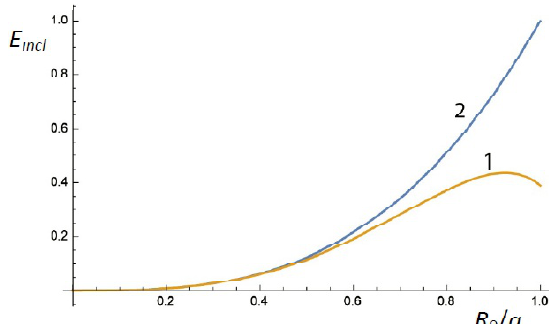
Fig. 5. The strain energy of a hemispherical dilata- tion inclusion E as a function of its normalized incl radius R / a in a sphere of finite radius a (curve 1) 0 and in an infinite medium (curve 2). The energy val- ues are given in units of 4  (1+  ) G  *2 a 3 /(3(1-  )) for 